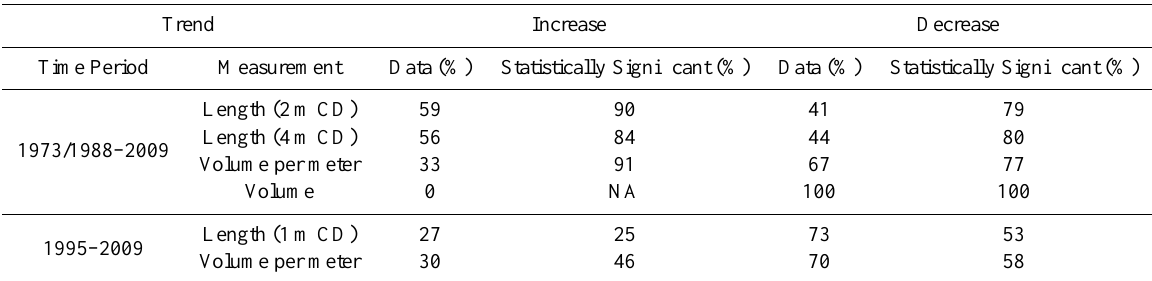
Fig. 4. Singular Spectrum Analysis of beach volume blocks showing the original time series by the solid line and the reconstructed time series shown by the dashed line. Each data point represents a 3 month interval. (a) Block Volume B – F, (b) Block Volume 1 – 18, (c) Block Volume 19 – 23, (d) Block Volume BR6 – BR9 (refer to Fig.3)